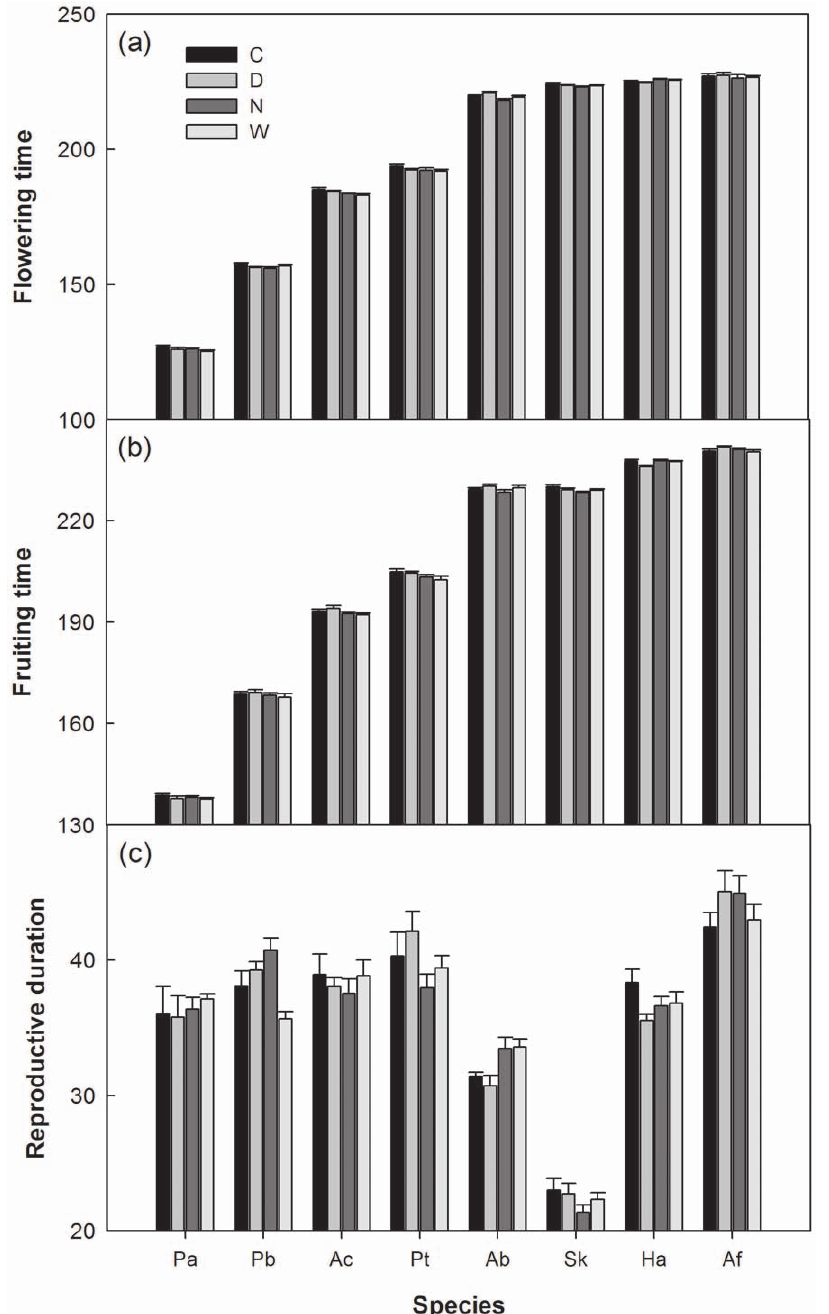
Figure 2. Species-level flowering time, fruiting time, and reproductive duration under control (C), day warming (D), night warming (N), and whole-day warming (W) treatments. Species are listed in the order of the mean time of buds first observed in the control plots over the four growing seasons, beginning in April with P. acaulis (Pa) and ending in October with A. frigida (Af). Inset panels represent the warming effects on phenological events of early (E), middle (M), and late (L) species. Data are mean 6 SE for advanced ( 2 ) or delayed ( + ) phenology, respectively. P. bifurca (Pb), A. cristatum (Ac), P. tanacetifolia (Pt), A. bidentatum (Ab), S. krylovii (Sk), and H. altaicus (Ha). doi:10.1371/journal.pone.0032088.g002 upon precipitation were found for 3 spring-summer species ( P. acaulis , A. cristatum , and P. tanacetifolia ; Fig. 6a, c, d), while negative relationships were detected on 2 autumn species ( A. bidentatum and H. altaicus ; Fig. 6f, g).